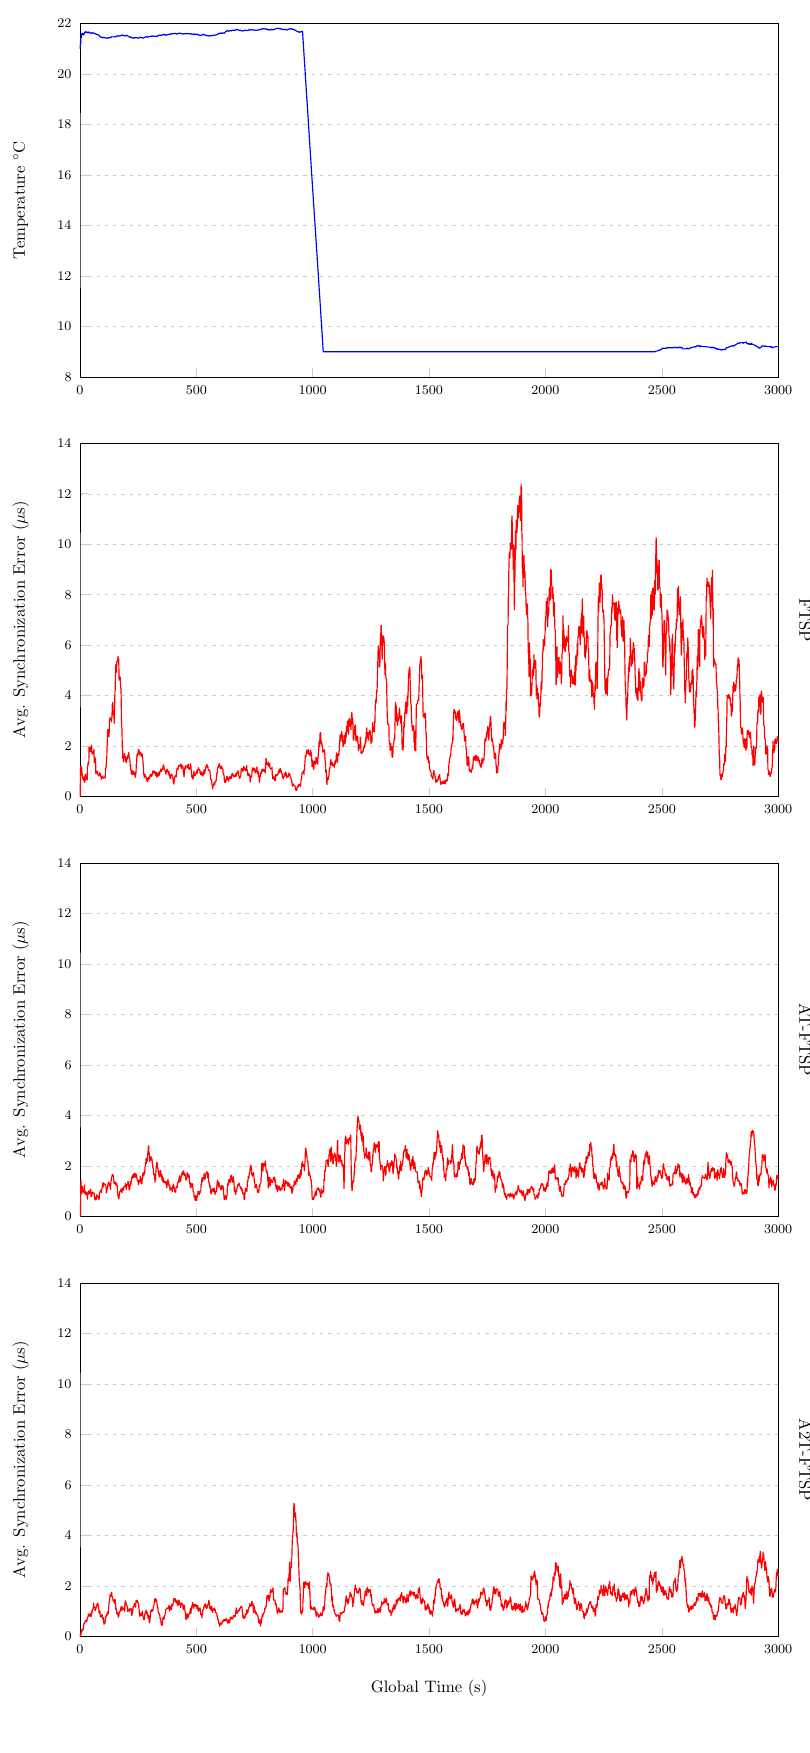
Figure 4. Low temperature